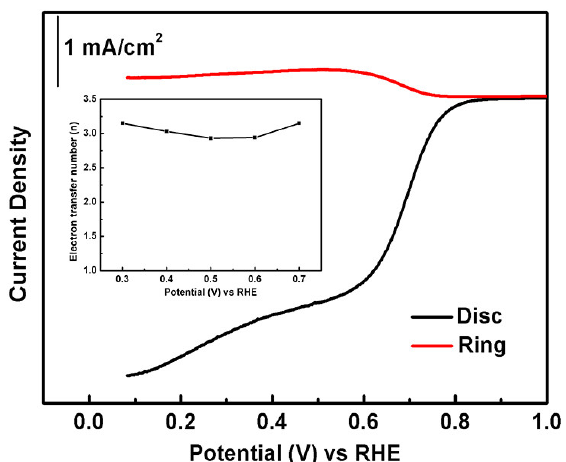
Figure 5. RRDE voltammograms of T4/T3 catalysts in the O 2 -saturated 0.1 M KOH solution with the sweep rate of 5 mV s −1 and the rotating rate of 1600 rpm. The ring potential is kept constant at 0.5 V vs. Ag/AgCl. The inset shows the calculated electron transfer number at different potentials.